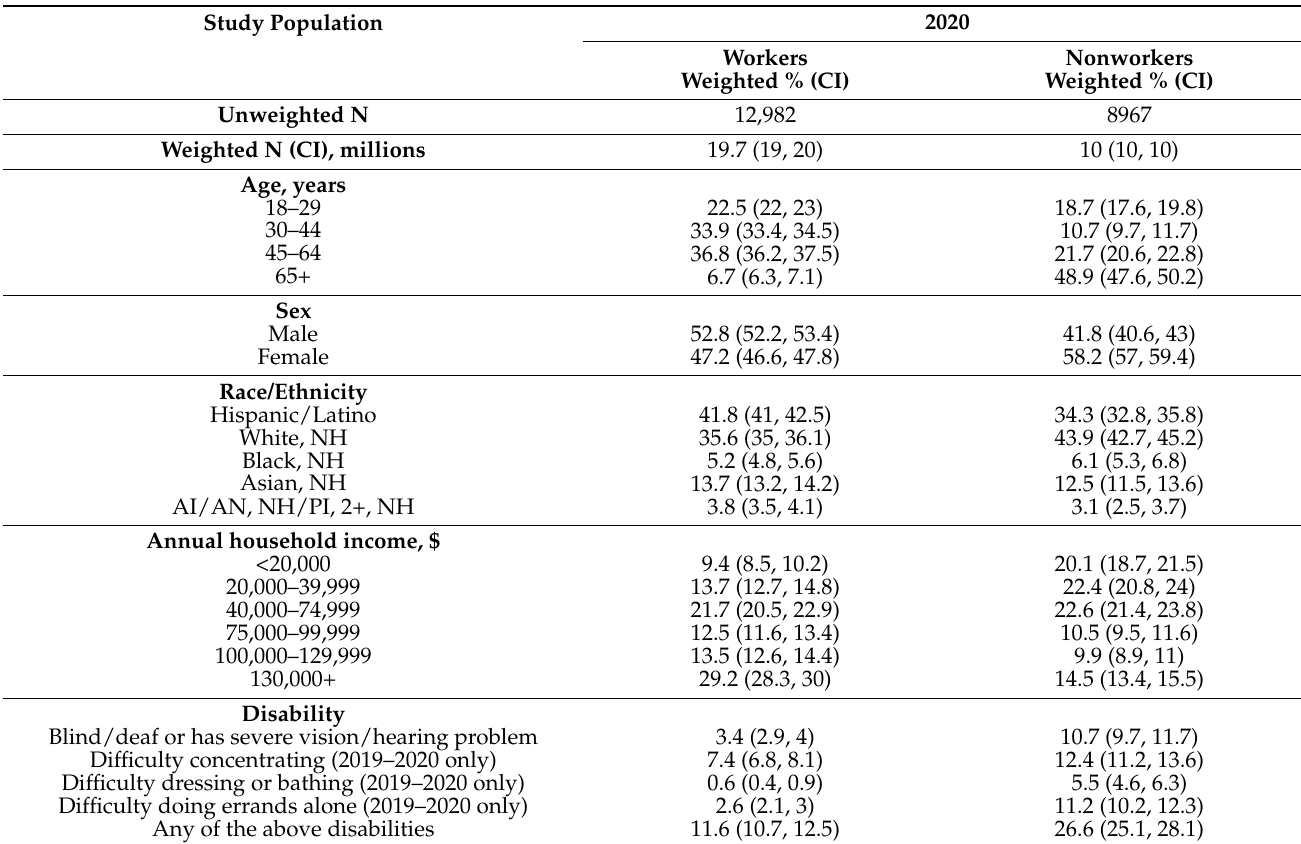
Table 1. Sociodemographic characteristics of study